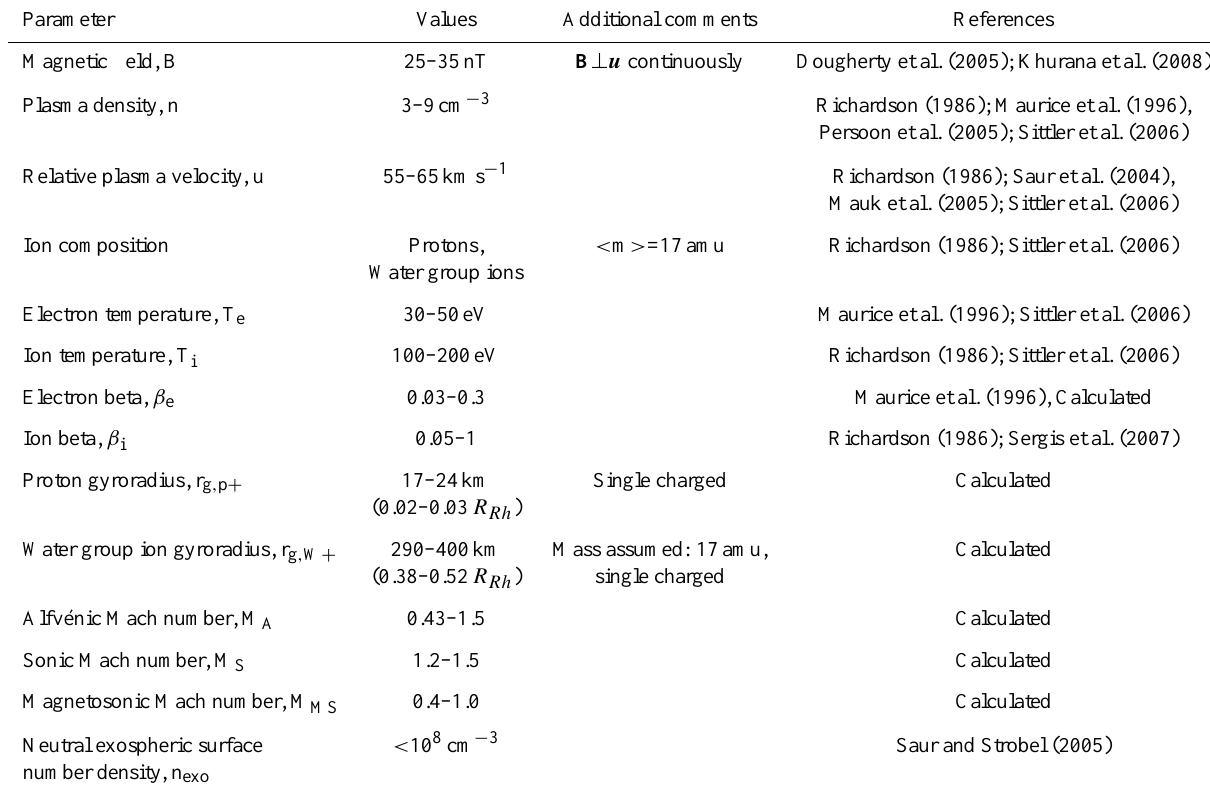
Table 1. Values and ranges of the various parameters describing Rhea’s space environment. We note that the value range of plasma moments could partly be attributed to the moment calculation